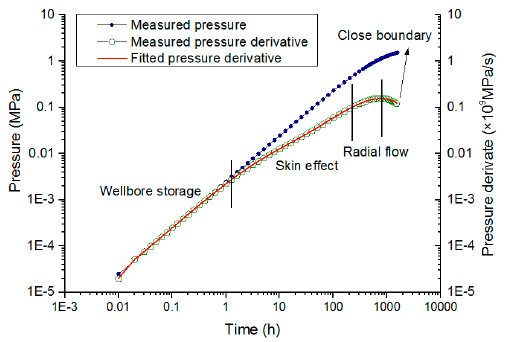
Figure 4. H3-1 deconvolution well-test double logarithmic curves.